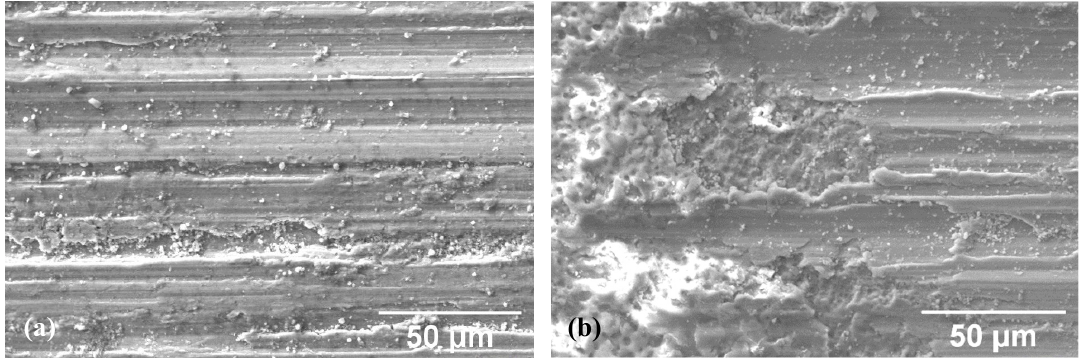
Figure 9. SEM images of wear scars on ( a ) untreated and ( b ) PEO-treated Ti-6Al-4V after the friction and wear transition that corresponds to the involvement of the substrate in the contact (i.e., coating failure).